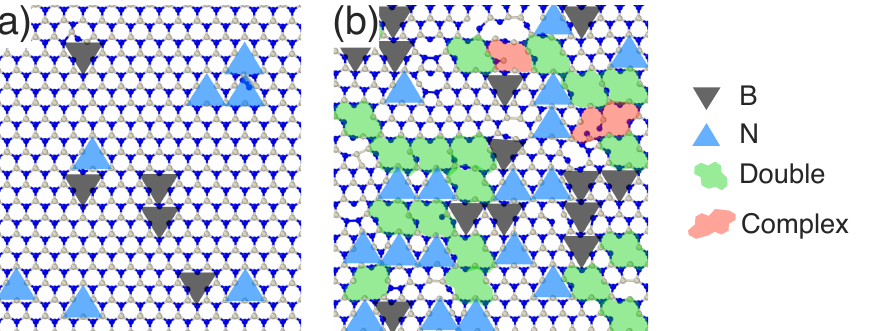
Figure 5. Atomic structure of h-BN sheet after irradiation with Ne ions having energy of ( a ) 50 eV and ( b ) 150